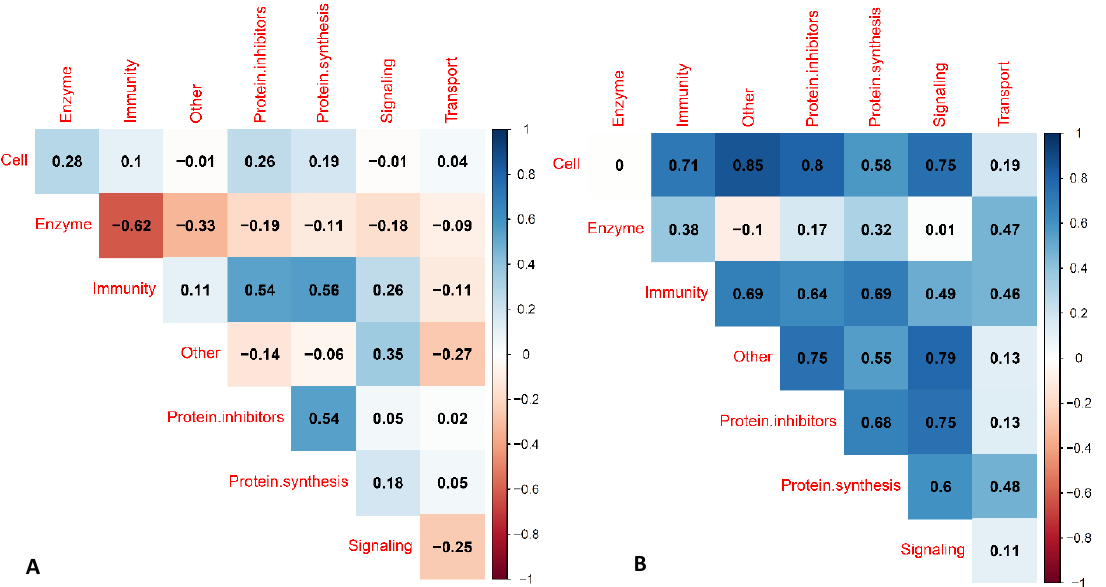
Figure 4. Calculated Pearson correlation coefficients between the different functional groups of serum proteins in Chinese and Dutch human milk, using the summed BCA equivalent values (g/L) over lactation. ( A ) Chinese human milk and ( B ) Dutch human milk. Table 1. The 15 most abundant serum proteins categorized per function in both Chinese and Dutch human milk during lactation, with their corresponding BCA equivalent values (g/L) values at week 1.